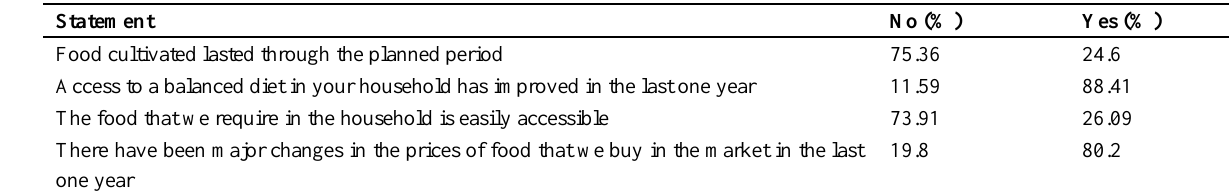
Table 1: Respondents Views on various Aspects of Food